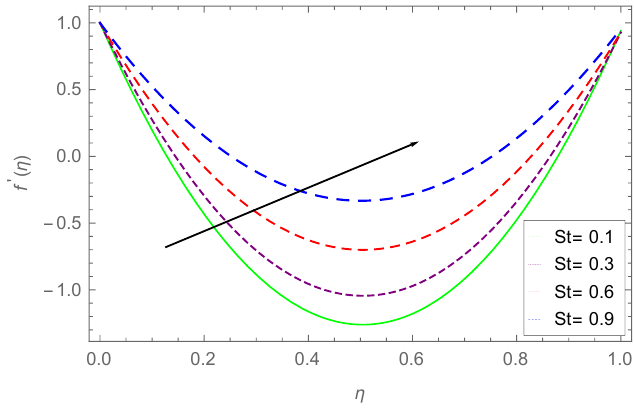
Figure 3. Impact of St on f (cid:48) ( η ) , when γ 1 = 0.2, β = 0.9, Gm = 0.8, Gr = 0.7, M =